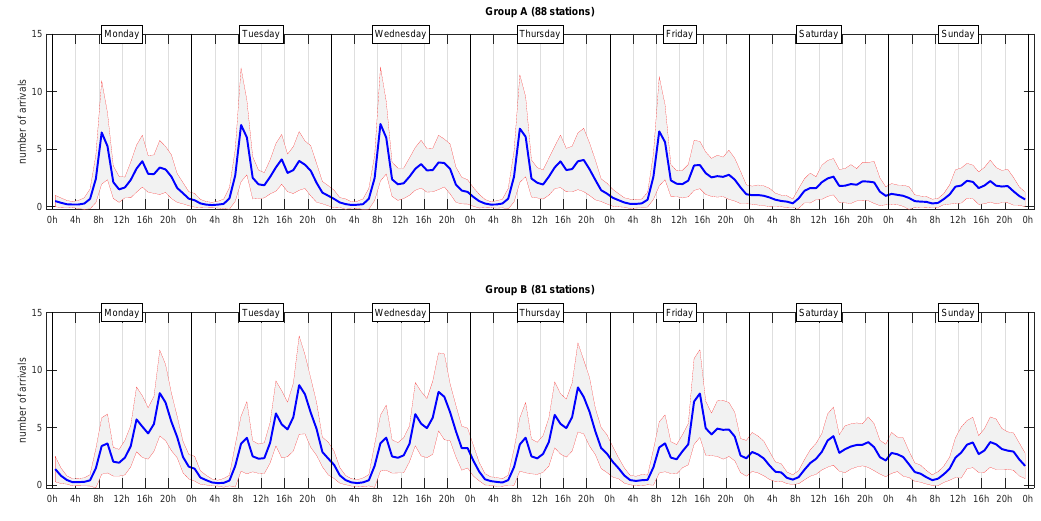
Figure 2. Weekly arrival profiles in clusters A and B . Mean plus/minus a standard